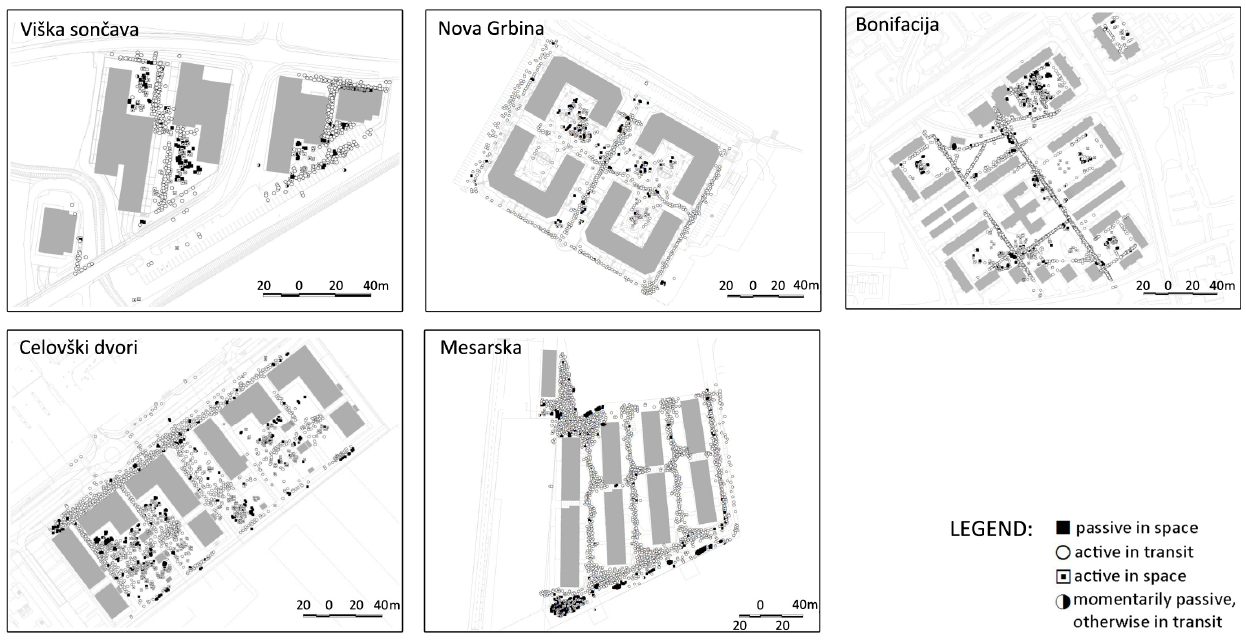
Figure 2. Graphical presentation of observation results according to the “Activity” category.